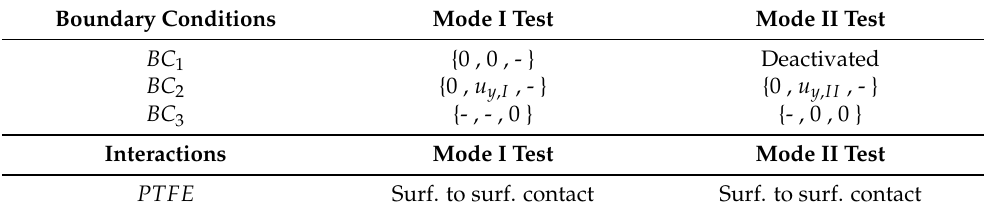
Table 2. Boundary conditions used in the numerical